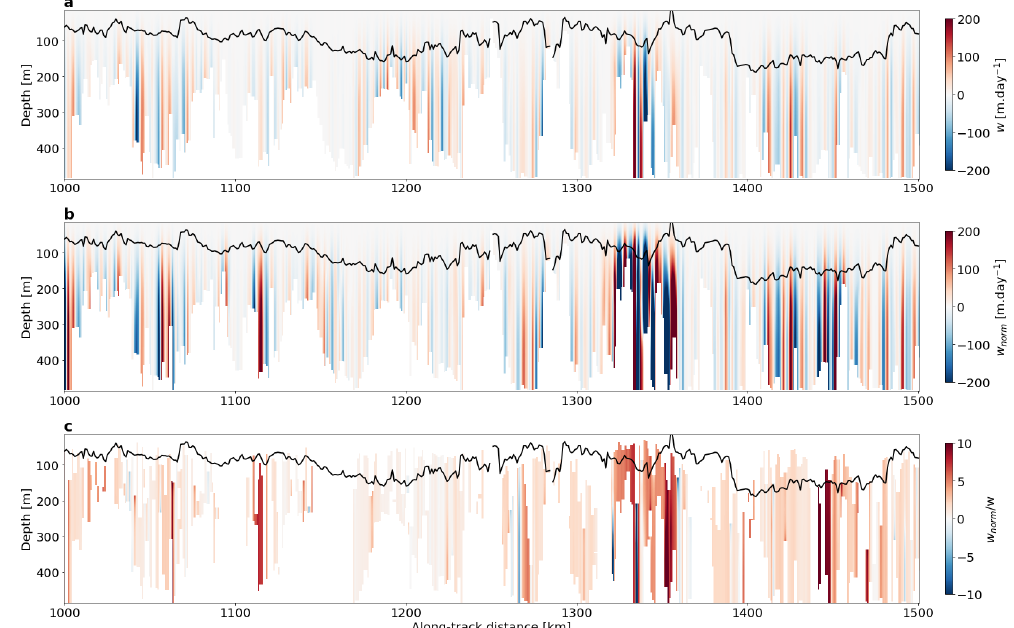
Figure 14. Vertical section of ( a ) vertical velocities w along x the curvilinear abscissa following the seal’s trajectory (in color in Figure 11), ( b ) vertical velocities w norm in the across-front direction, ( c ) w norm / w for | w | > 5 m day − 1 . Vertical velocities are derived by solving a 2-D QG omega equation (Equation (2)). The MLD is shown in black and is defined as the level of a 0.03 kg m − 3 density increase from 15 m